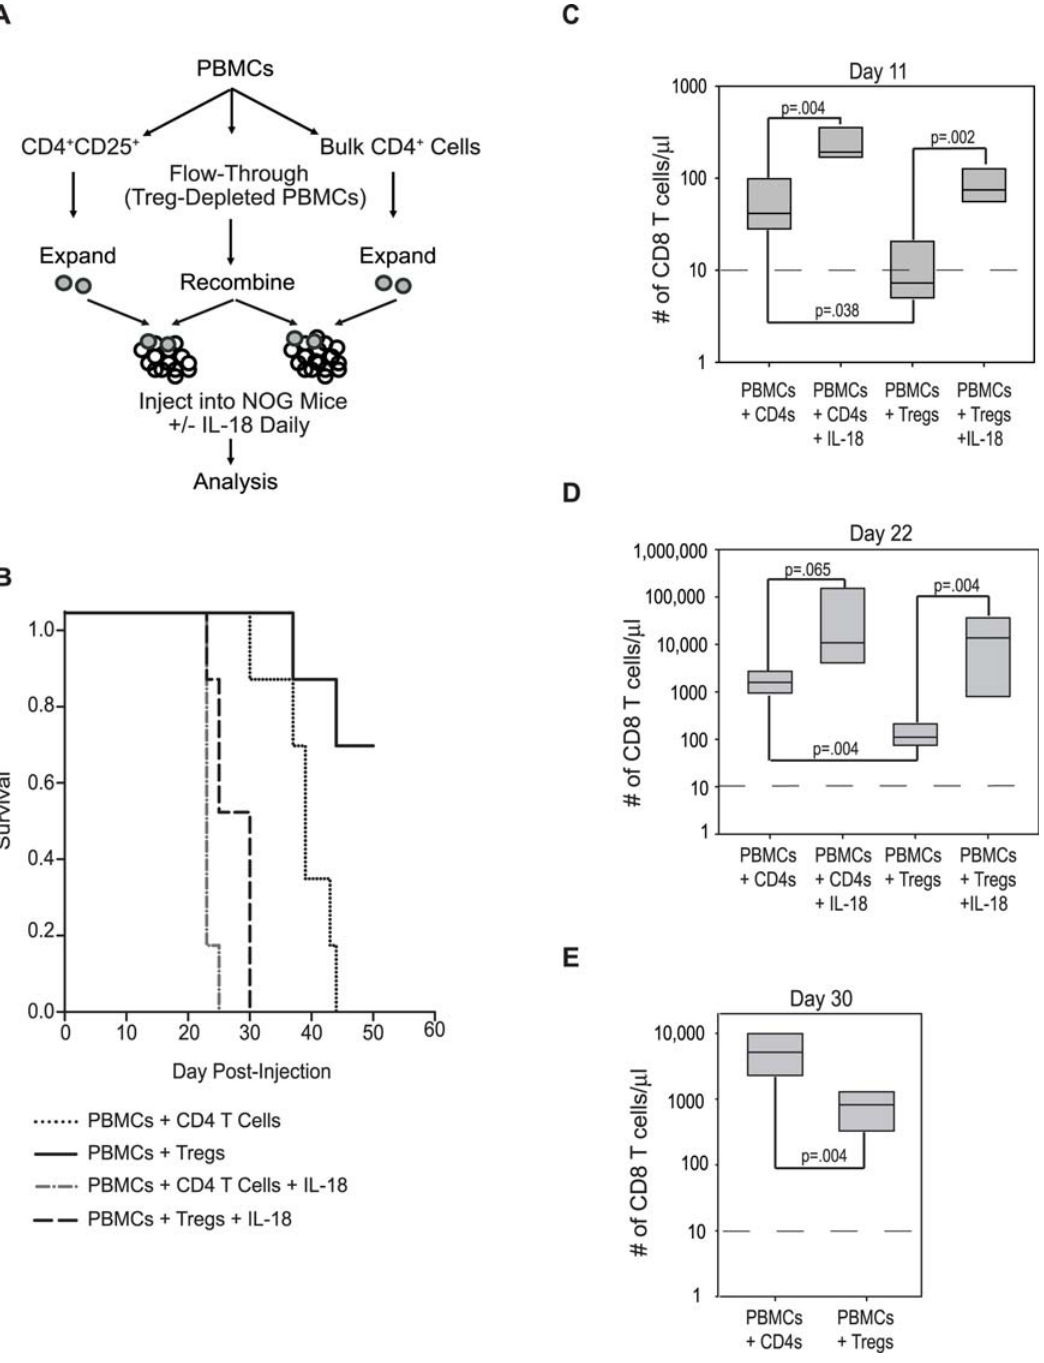
Figure 6. Effect of Human IL-18 on Treg-Induced Delay of Xenogeneic GVHD in NOG Mice. NOG mice were injected with 2 6 10 7 Treg- depleted human PBMCs supplemented with either 4 million autologous CD4 + CD25 2 T cells (‘‘CD4 T cells’’) or 4 million autologous, ex vivo-expanded CD4 + CD25 + cells (‘‘Tregs’’). One cohort of each group received daily injections of 15 m g recombinant human IL-18 for three weeks. Human cell engraftment in the peripheral blood was measured 11, 22, and 30 days post-injection. The animals were followed until the onset of xenogeneic GVHD. (A) Experimental overview. (B) Kaplan-Meier Survival Analysis (Log-Rank) of the indicated cohorts of mice. The Holm-Sidak method for multiple comparisons (significance level 0.05) was performed, and showed significant differences between all groups. ( C–E ) Peripheral blood levels of human CD8 + T cells were measured at Day 11 ( C ), Day 22 ( D ), and Day 30 ( E ) post-injection. Note that all IL-18-treated animals are not represented in panel E due to their death from acute GVHD.